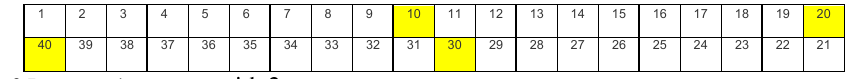
Fig 2 Representing a tape with 2